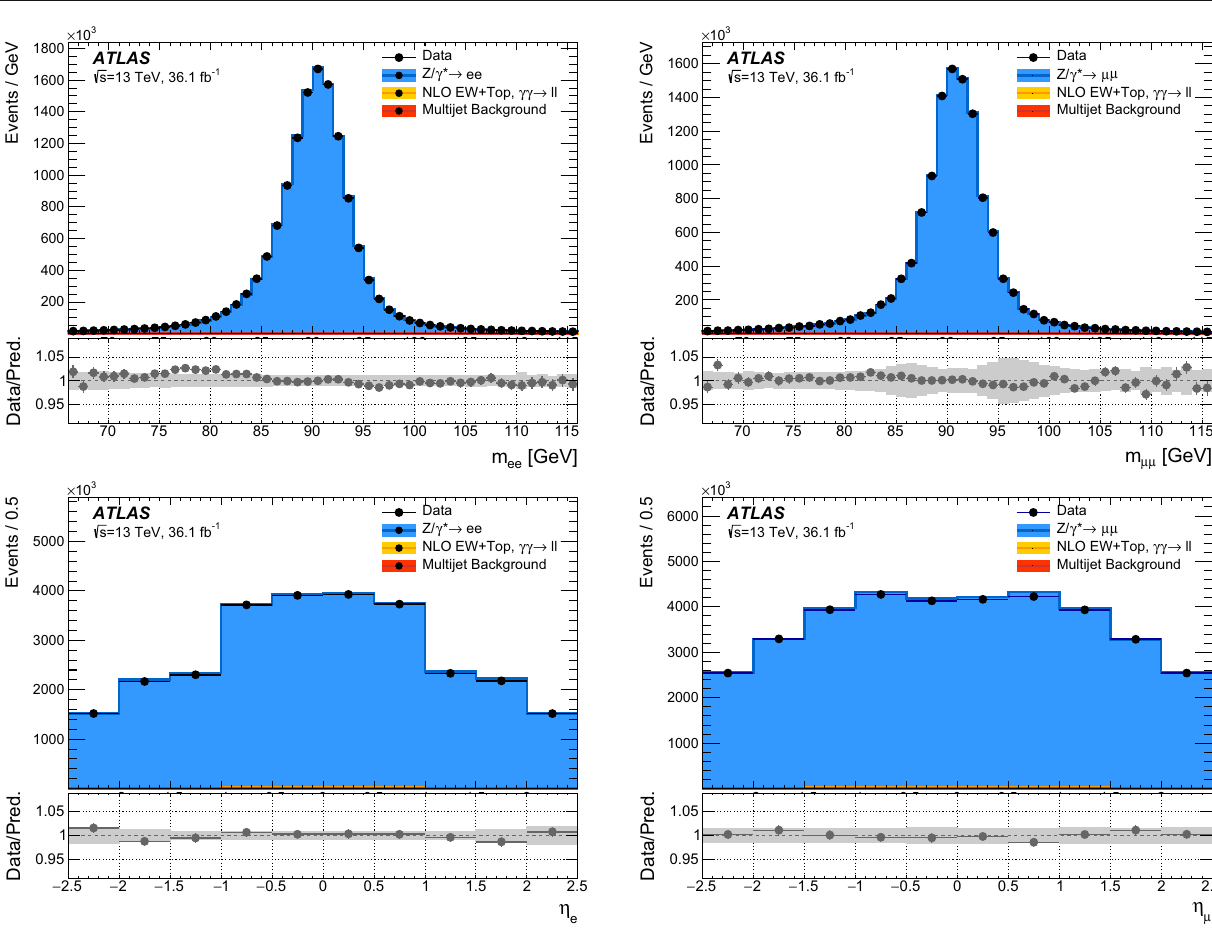
uncertainties of the data points are generally smaller than the size of the markers. The predictions of the MC signal sample together with the MC background samples are normalized to the integral of the data and the total experimental uncertainty of the predicted values is shown as a grey band in the ratio of the prediction to